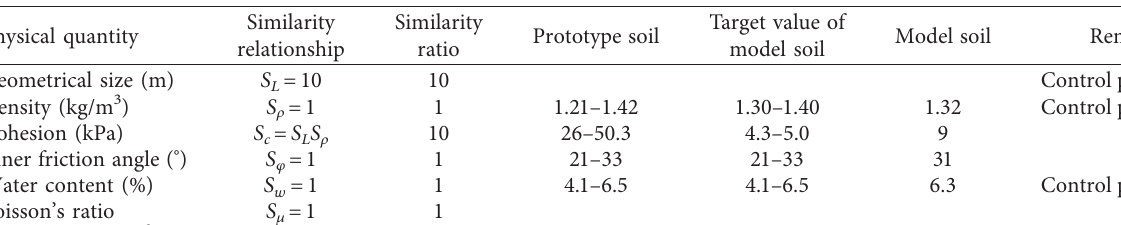
Figure 2: Shaking table slope model. (a) Front view. (b) Side view. Table 1: Similarity relationship.